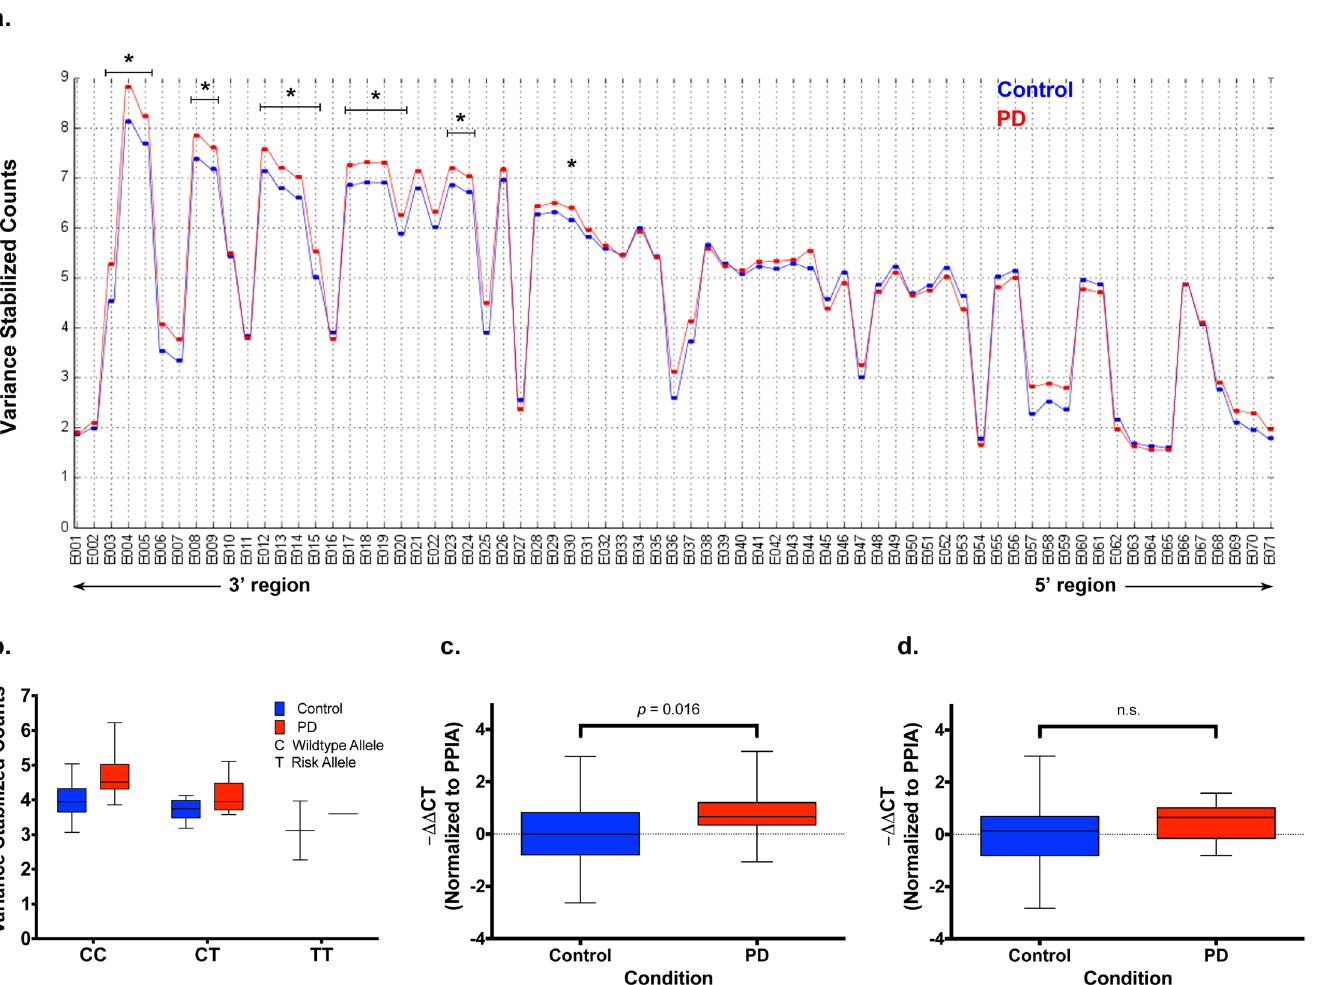
Fig 1. GAK Gencode exons in the 3 ’ region are differentially expressed in PD. (A) The mean normalized expression for PD cases and controls is plotted for each of the 71 GAK exon feature bins (x-axis). Exon 1 corresponds to the 3 ’ end of the gene, while Exon 71 corresponds to the 5 ’ end. Brackets indicate groups of exons significantly increased in PD relative to control ( * = q -value < 0.05). (B) The mean normalized expression of GAK exon 25 ( GAK25 ) is plotted for each stratified group. The samples are stratified by case status (Control and PD) and by genotype in an additive fashion (CC = Major allele homozygote, CT = Heterozygote, TT = Risk allele homozygote). (C and D) - ΔΔ CT (log2 fold change) of GAK normalized to PPIA is plotted for all control and PD samples for ( c ) GAK 3 ’ exons and ( d ) GAK 5 ’ exons.